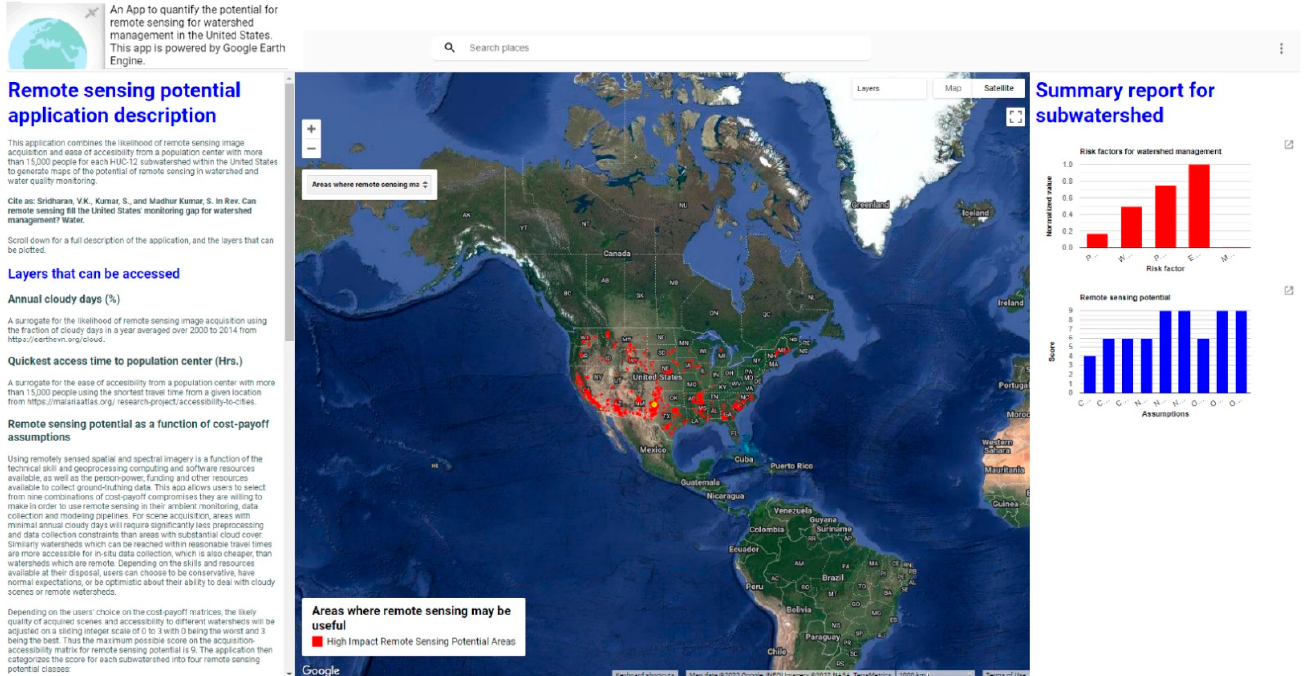
Figure 6. Google Earth Engine application to demonstrate the potential of remote sensing in moni- toring watershed management in the United States. Attribution: Map Data © 2022 Google INEGI Imagery © 2022 NASA, TerraMetrics.